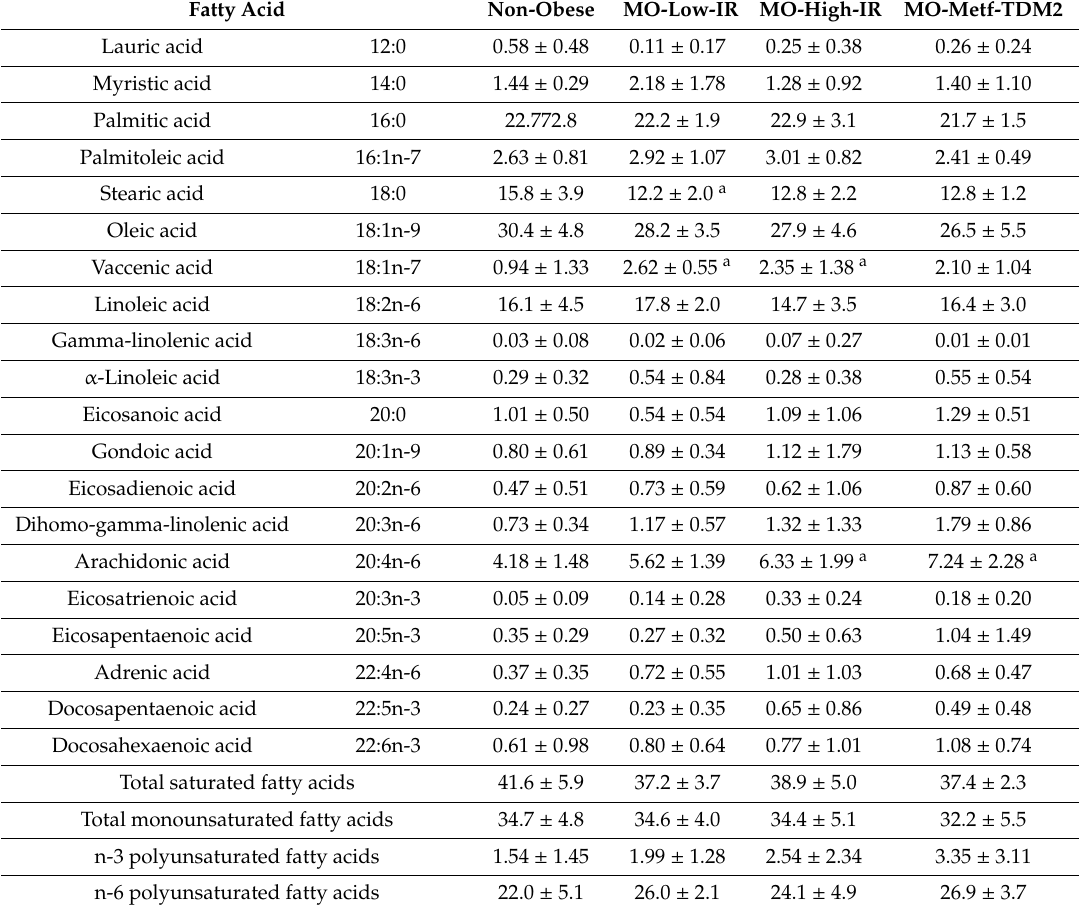
Table 2. Fatty acid composition of phospholipids in visceral adipose tissue from non-obese patients and morbid obese